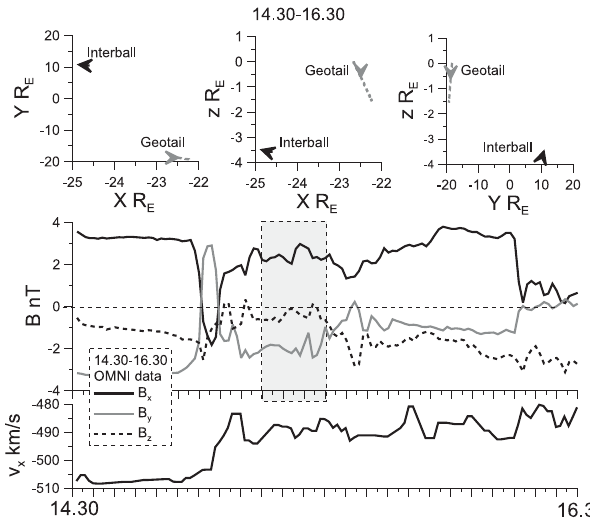
Fig. 11. Positions of Interball-tail and Geotail spacecraft on 15 De- cember 1996 from 02:00 to 04:00. OMNI data: magnetic field and solar wind